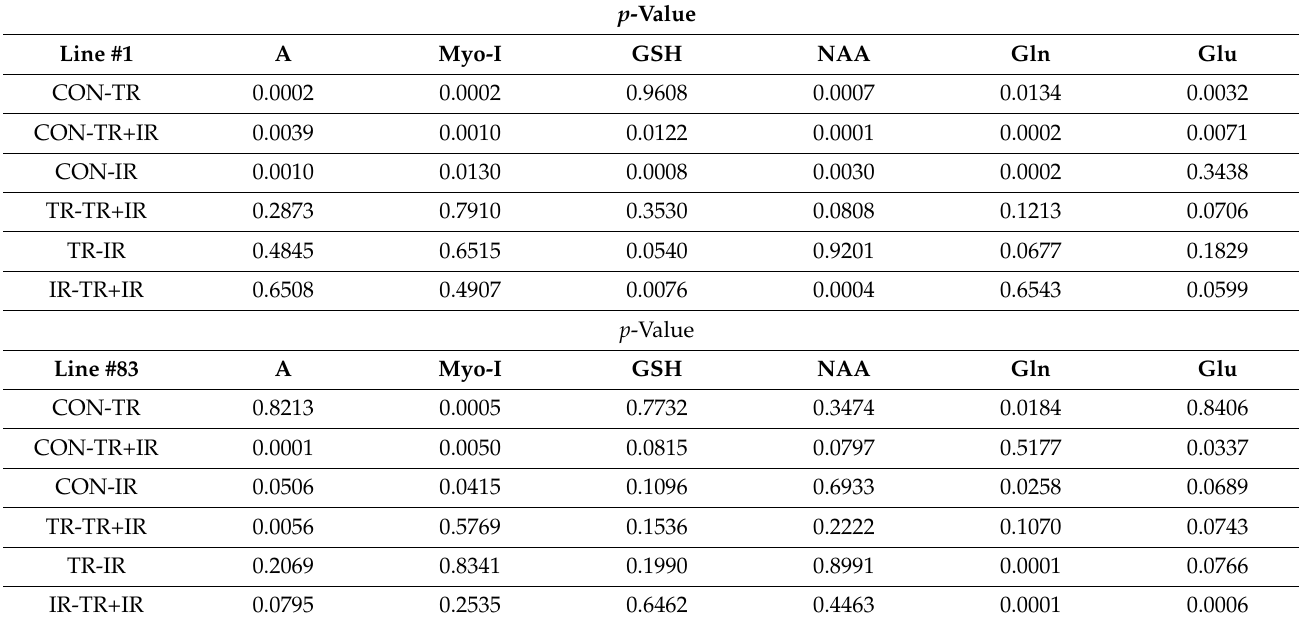
Table 1. Student’s t -test p values for the indicated metabolites between different condition samples. p -Value